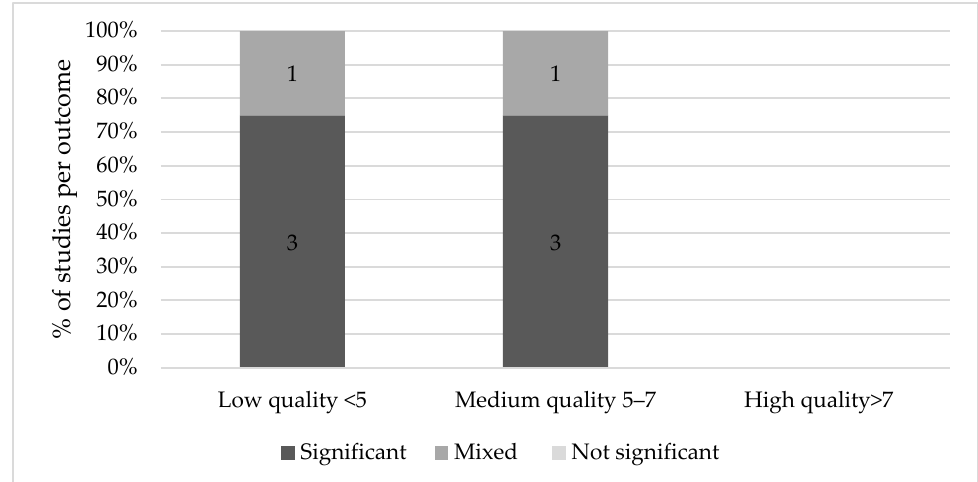
Figure 5. Results on Ramadan fasting during pregnancy and long-term